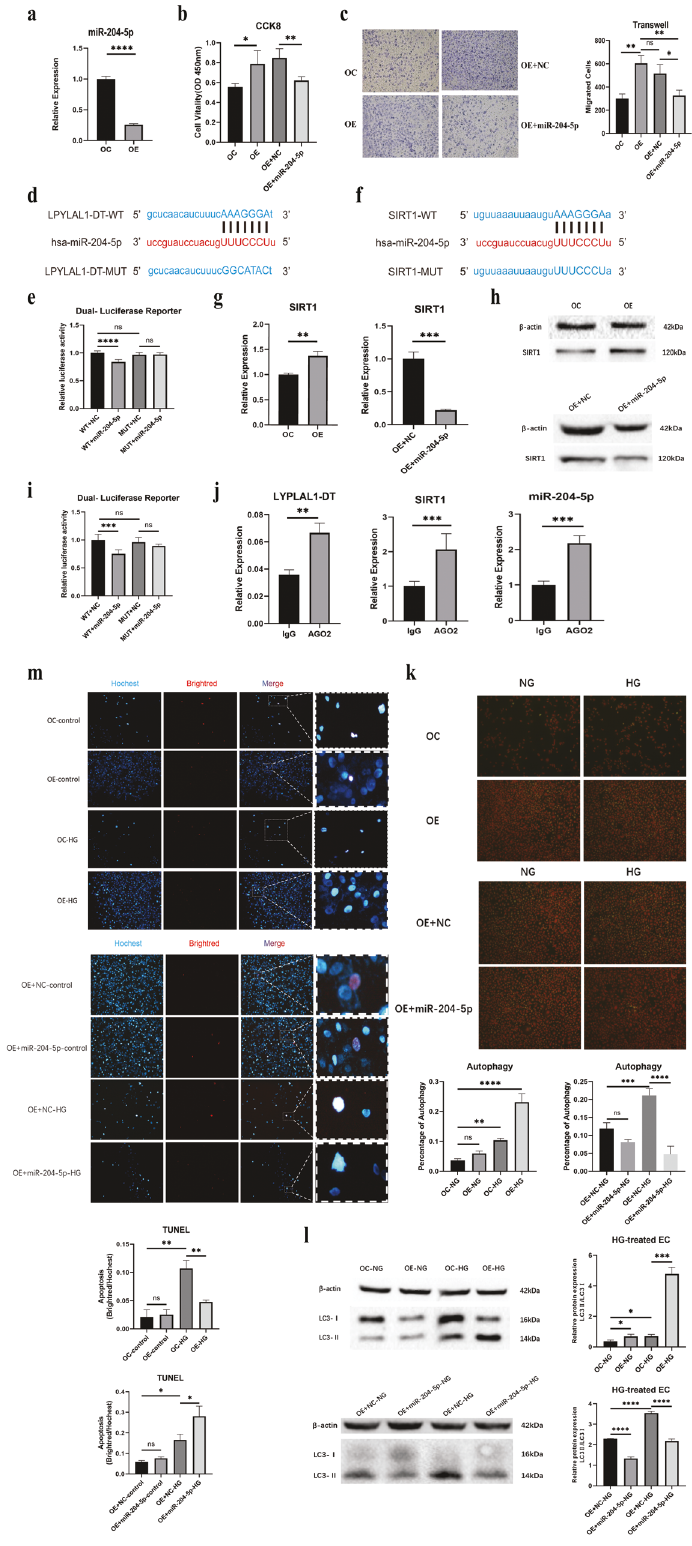
arterial thrombosis [39], we believe SIRT1 plays a critical role in DMC. Hence, we present evidence that LYPLAL1-DT effectively protects against vascular endothelial injury in diabetes associated complications via the LYPLAL1-DT -miR-204-5p/SIRT1 pathway.